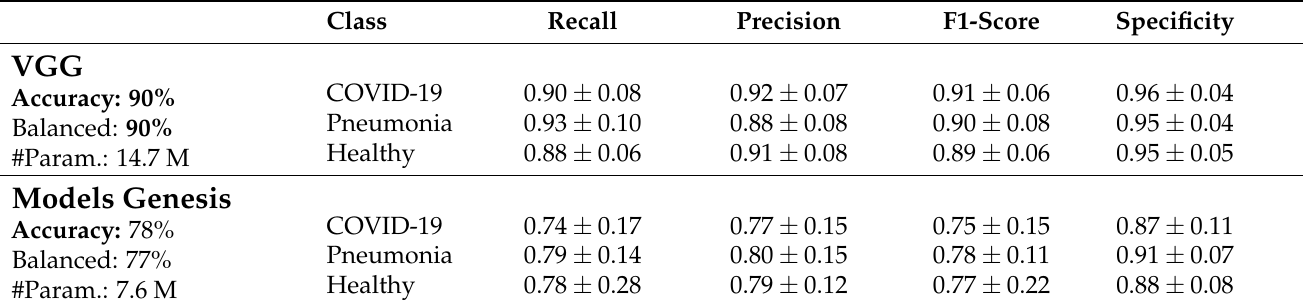
Table 3. Video classification results. The frame-based model VGG-CAM outperforms the 3D CNN Models Genesis in all shown metrics, displaying high accuracy (94%), recall, precision for COVID-19 and pneumonia detection. Class Recall Precision F1-Score Specificity